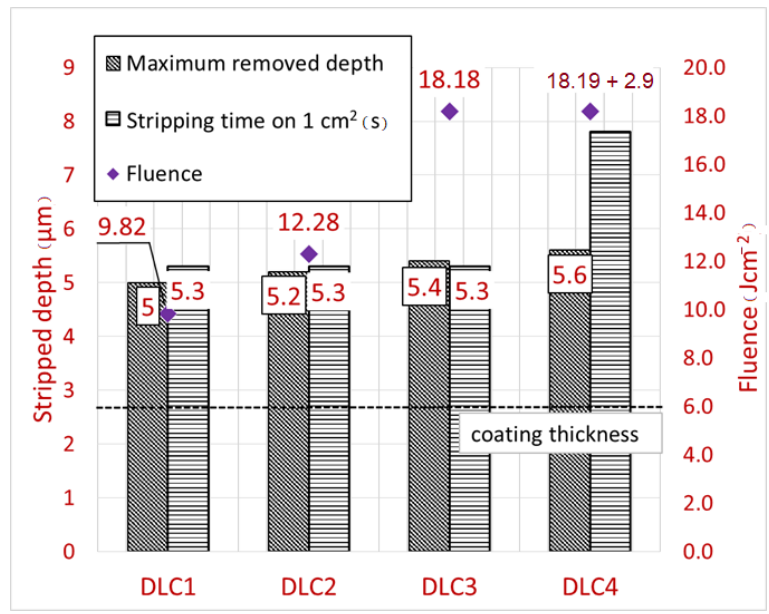
Figure 7. Bar chart of removed depth and working time for laser stripping of DLC C coatings. The shortest coating removal time for 1 cm 2 was 5.4 s for samples DLC1, DLC2 and DLC3. The longest time needed to remove 1 cm 2 was 7.8 s, which included two passes. In all cases, the maximum depth of the removed layer exceeded the thickness of the DLC C coating (2.7 µ m). The smallest removed depth of 5 µ m was measured for sample DLC1, which was fabricated with the smallest fluence. In contrast, sample DLC4, produced with two passes and the highest energy, resulted in a maximum removed depth of 5.6 µ m. The depth increase was only 0.6 µ m although twice as much energy was used. Examining the influence of the second high frequency pass, it was observed that there was a small increase in removed depth for quite a large increase in working time. Figure 7 also makes it apparent that the removed depth does not increase as the fluence increases and stays constant in comparison with the AlTiN coating removal. This may be due to the different ablation behaviour of the DLC C multilayer coating. Figure 8 presents a comparison of the surface roughness measured in the X and